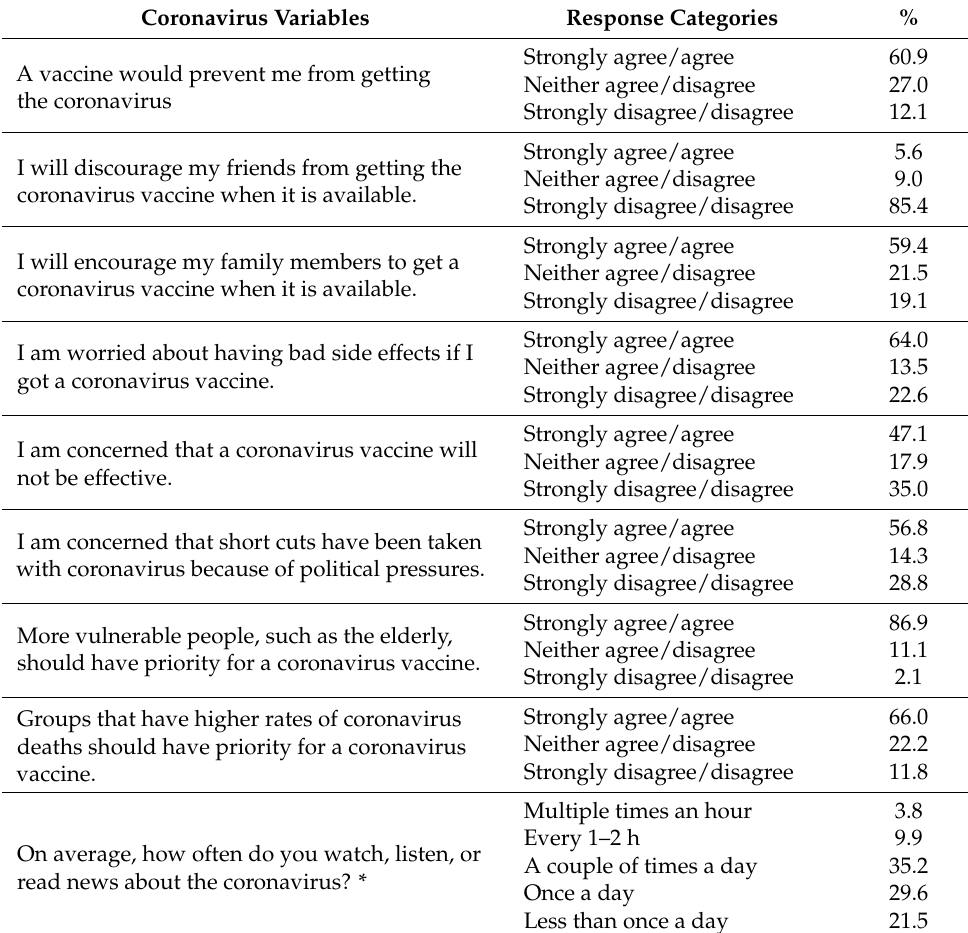
Table 2. Descriptive statistics on vaccine attitudes, behaviors, and news consumption frequency among study participants in the US, 2020 ( N =